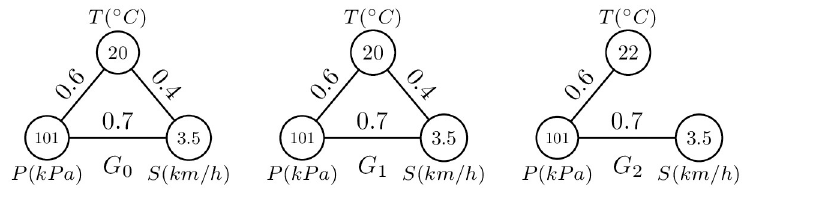
Fig 1. Example of the